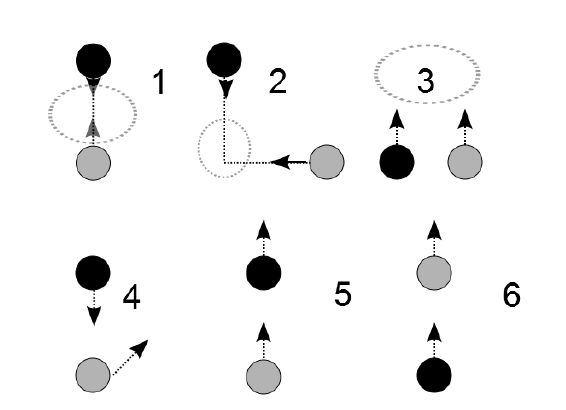
Figure 5. The formations observed in the experiment. Formation 1-3 are F- formations [15]: 1. Vis-a-vis, 2. L-shape, 3. Side-by-side, 4. Look- away, 5. Ahead and 6. Follow. The Giraff is grey and the local user is black. The dotted ovals denote the shared interaction space, O- space.